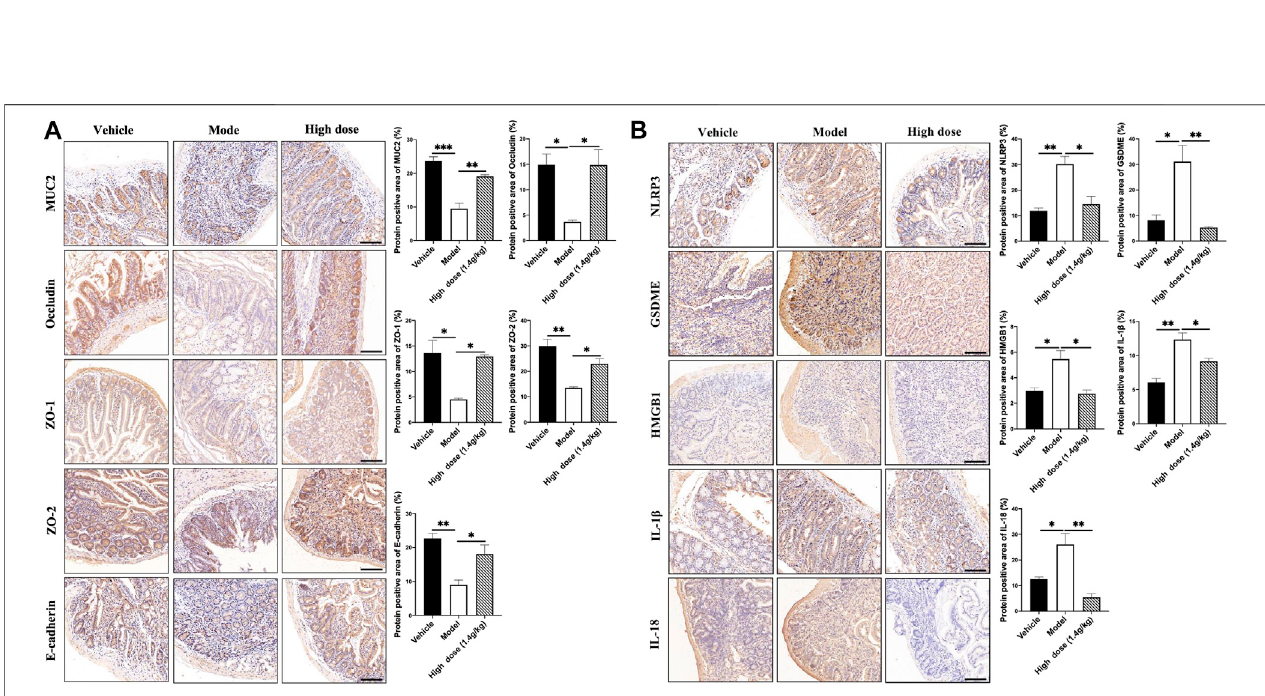
FIGURE8| EffectsofQCWZDontheintestinalbarrierandpyroptosisinApc min/+ mice. (A) LevelsofMUC2,occludin,ZO-1,ZO-2,andE-cadherininApc min/+ mice (magni fi cation: ×200). (B) Levels of NLRP3 , GSDME, HMGB1, IL-1 β , and IL-18 in Apc min/+ mice (magni fi cation: ×200). High dose: 1.4 g/kg, * p < 0.05, ** p < 0.01.